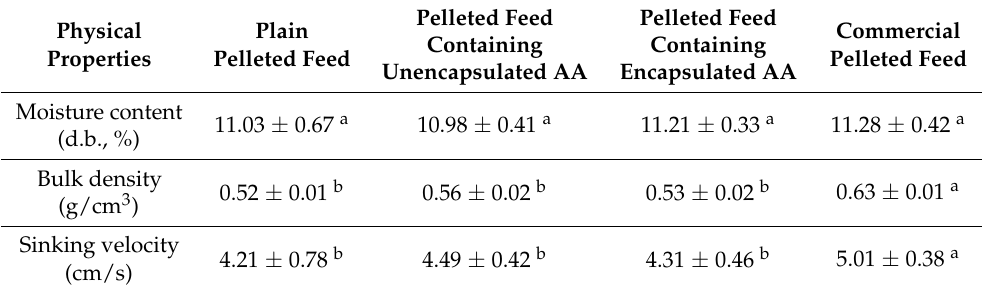
Table 2. Physical properties of pelleted feed